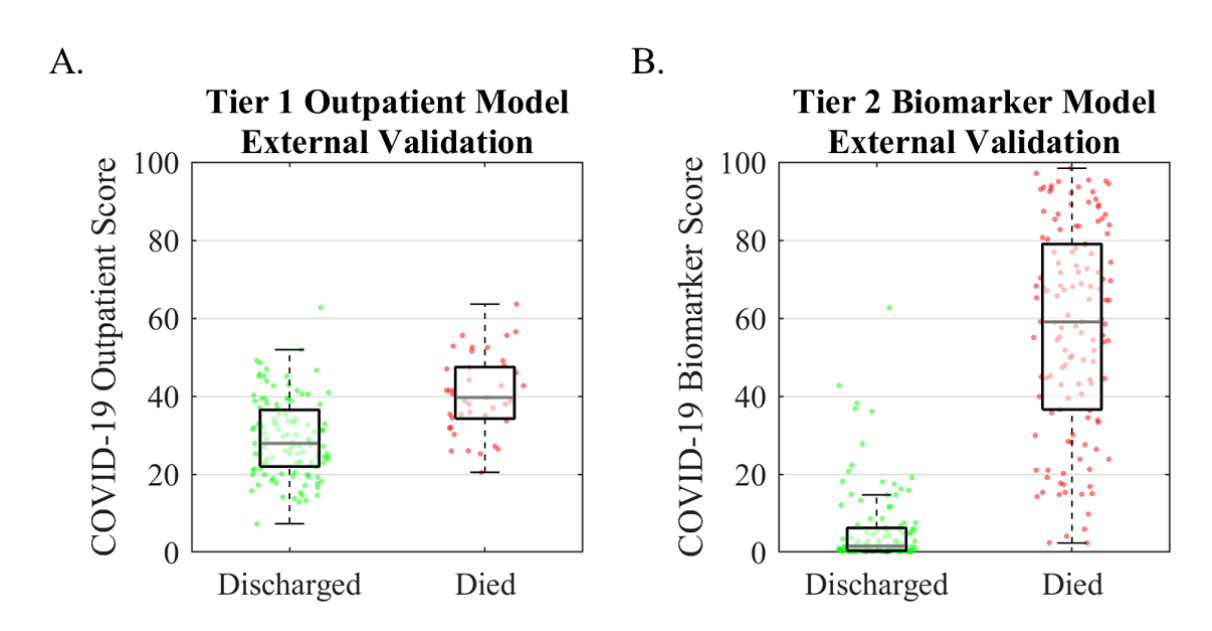
Figure 4. External validation results. A. The Tier 1 Outpatient Model was evaluated using data from patients with COVID-19 at Zhongnan Hospital of Wuhan University [26]. B. The Tier 2 Biomarker Model was evaluated using data from patients with COVID-19 at Tongji Hospital [21]. COVID-19: coronavirus disease.